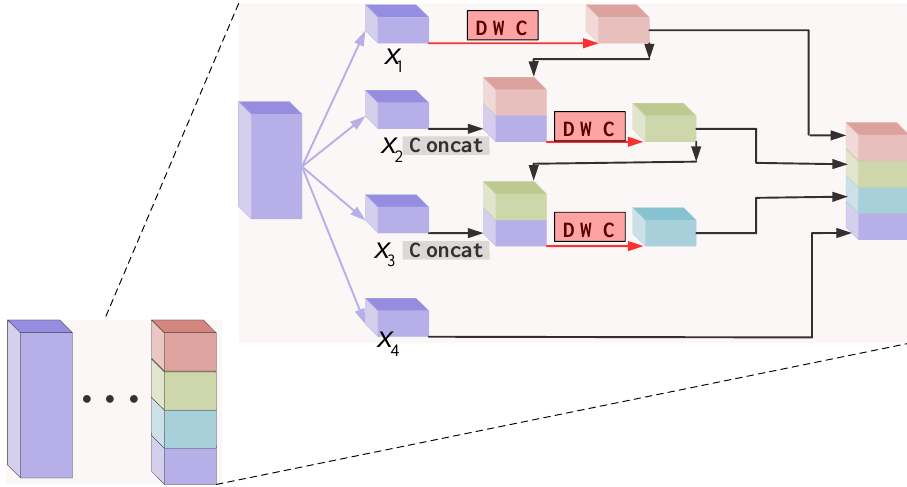
Figure 9. Hierarchical-wise convolution fusion module D. (Group 4 maps directly to the next layer) .